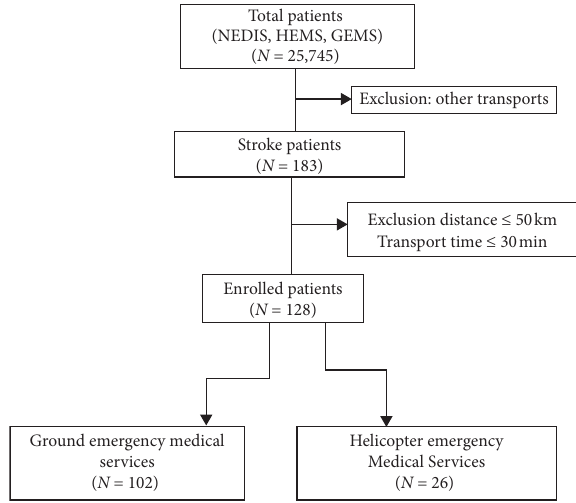
Figure 2: Flowchart of study patients. NEDIS: National Emergency Database Information